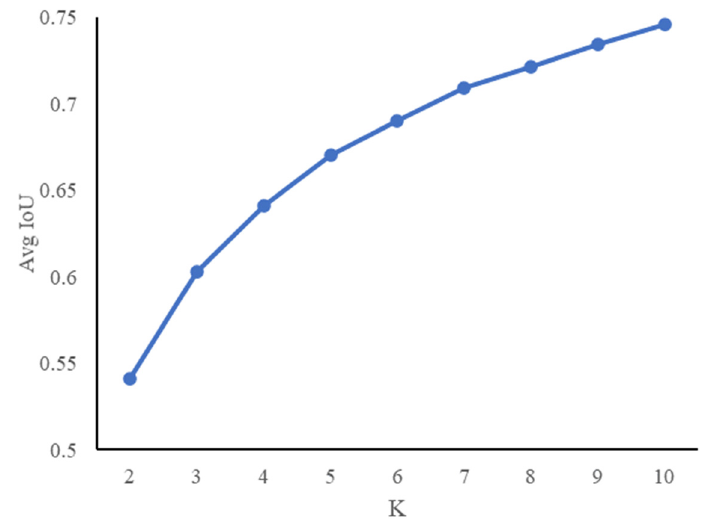
Figure 3. K-means clustering analysis result.